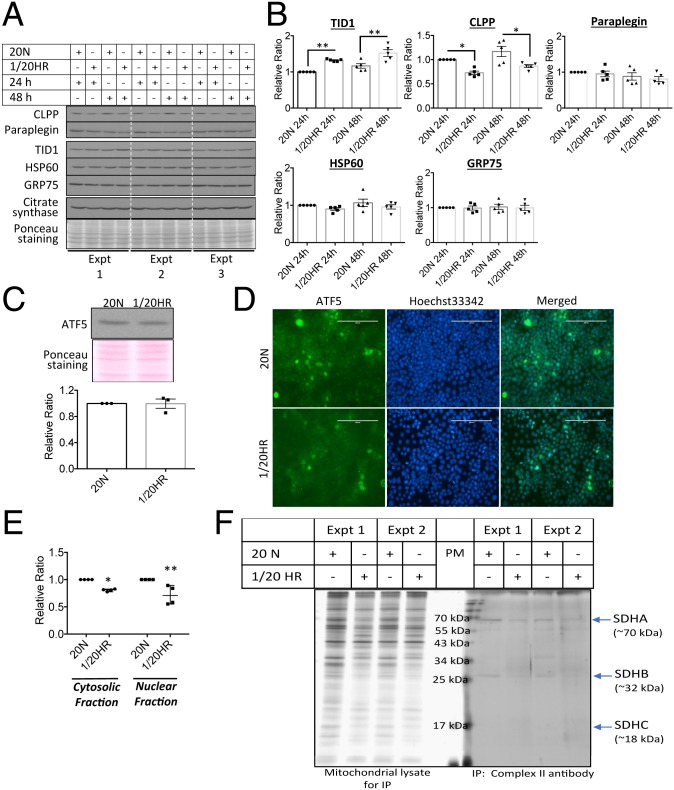
rHR activates a noncanonical UPRmt pathways. (A and B) rHR triggers noncanonical UPRmt pathways. BeWo cells were subjected to rHR for 24 and 48 h. Western blot was used for measurement expression of UPRmt molecular markers CLPP, paraplegin, TID1, HSP60, GRP75, and CS. Data were normalized to CS and are expressed as mean ± SEM, n = 5. *P < 0.05; **P < 0.01 (2-tailed paired t test at either 24 h or 48 h). (C–E) No increase in cellular expression but decreased nuclear translocation of ATF5 under rHR. Cells were exposed to 48 h of rHR. Western blot was used to quantify ATF5 while immunocytochemistry and subcellular fractionation was used to show its cellular localization. Data are presented as mean ± SEM, n = 3 to 4. *P < 0.05; **P < 0.01 (2-way ANOVA with Sidak’s multiple comparisons test). Magnification, 200×. (Scale bar: 200 μm.) (F) Potential conformation change of ETC complexes. Isolated mitochondria were subjected to immunoprecipitation with conformation-sensitive mitoprofile complex II antibody to pull out complex II before resolving in SDS/PAGE gel. Silver staining was used to reveal 4 subunits of complex II. The 20 N indicates cells were incubated under normoxic conditions with 20% O2 for 24 or 48 h; 1/20 HR indicates cells were exposed to a 6-h cyclic pattern of 1% and 20% O2 for 24 or 48 h.